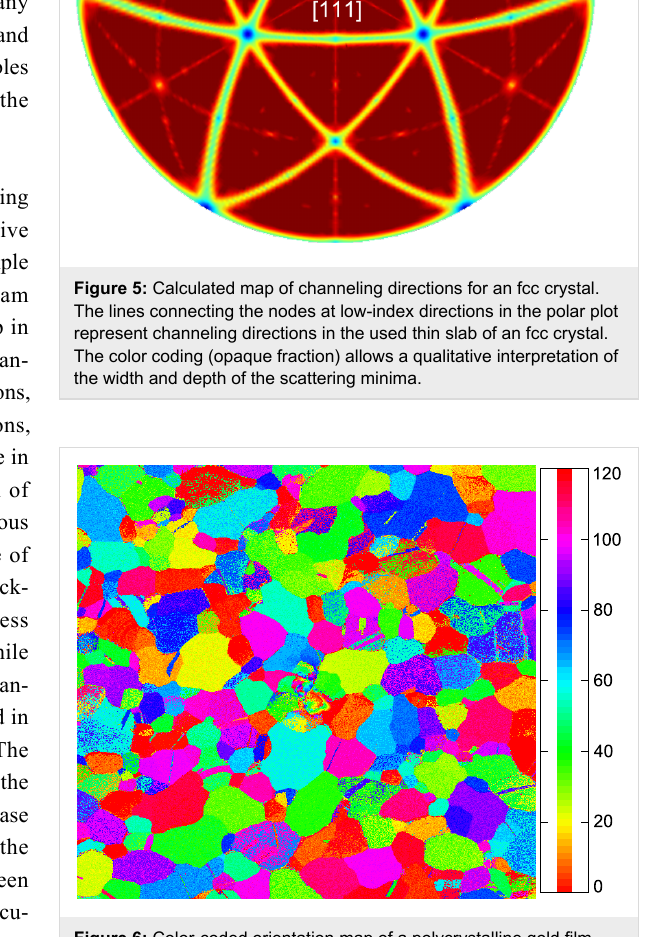
Figure 6: Color-coded orientation map of a polycrystalline gold film. The colors indicate the azimuthal angle around the [111] surface normal for a 35° sample tilt at which a <110> direction is aligned with the incoming helium ion beam. Parts of the data set used are presented in Figure